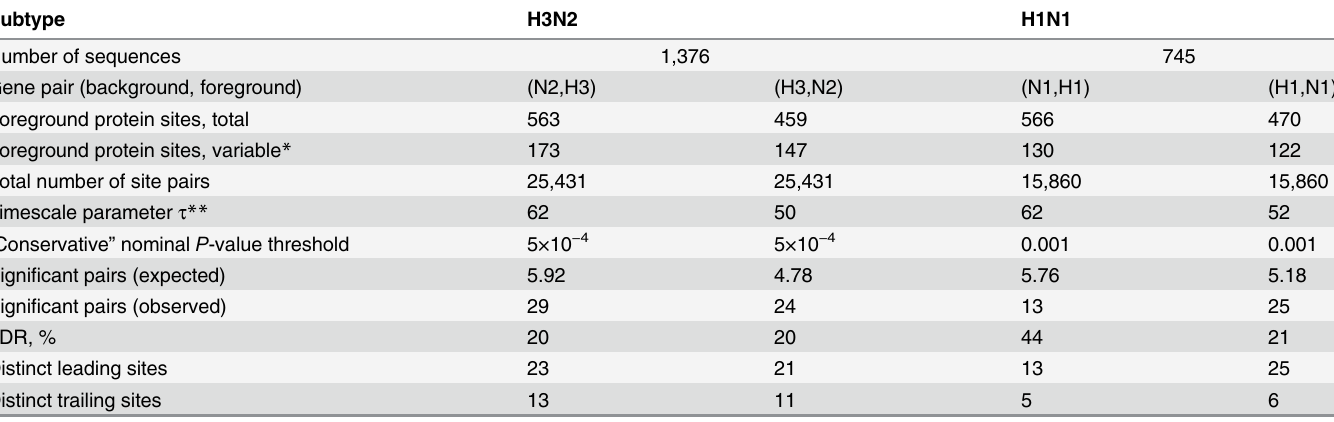
Table 1. Pairs of sites in HA and NA evolving under positive inter-gene